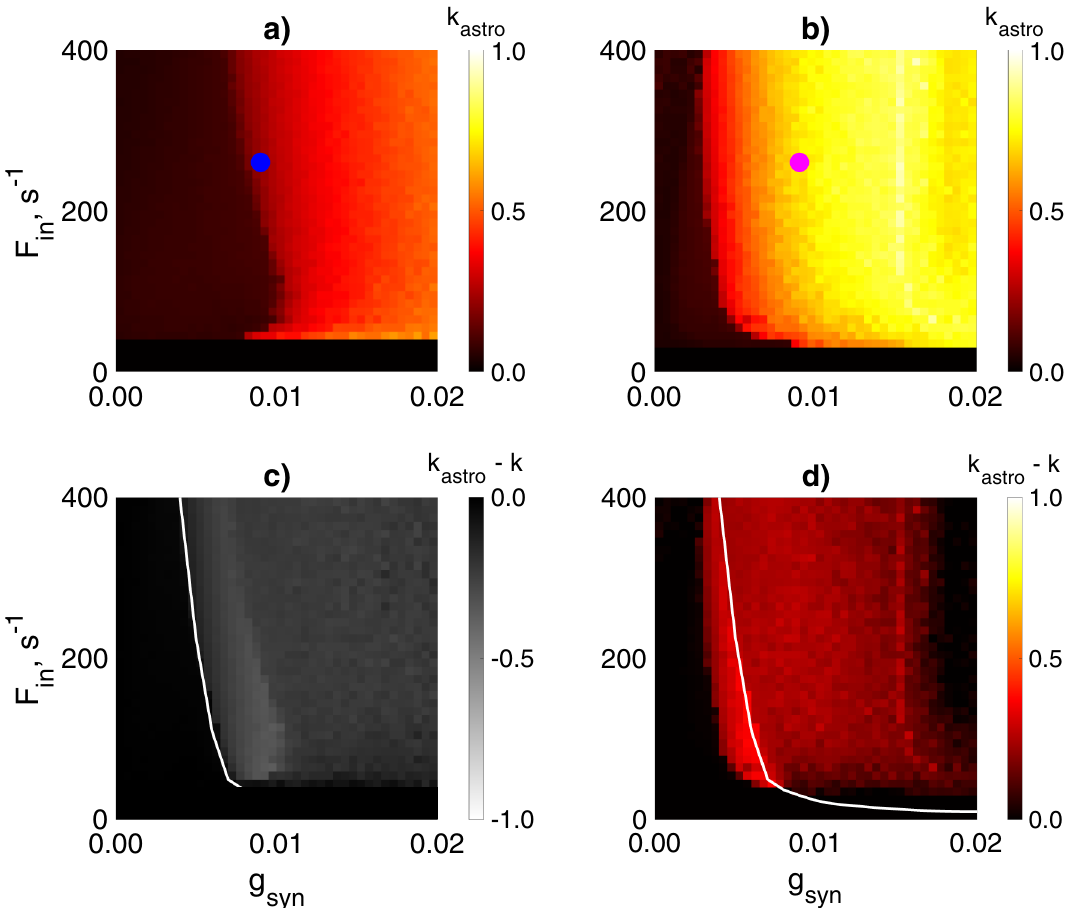
Figure 4. Influence of the astrocyte-induced modulation of the inhibitory synaptic transmission on the interneuron network coherence. Mean network coherence ( k astro ) during astrocytic regulation of synaptic transmission is plotted against the frequency of excitatory inputs ( F in ) and the synaptic weight between interneurons ( g syn ) for astrocyte-mediated depression, g astro = − 0.8 , ( a ) and facilitation, g astro = 1.2 , ( b ) of the inhibitory synapses. Filled circles indicate the parameter settings used in the simulations shown in Fig. 3. ( c ) Difference between ( a ) and Fig. 2c. ( d ) Difference between ( b ) and Fig. 2c. The white line corresponds to the border of the coherence region in the interneuron network without astrocyte (Fig. 2c). Each pixel represents an = 0.7 mS/cm 2 average of over 10 simulations. g syn P